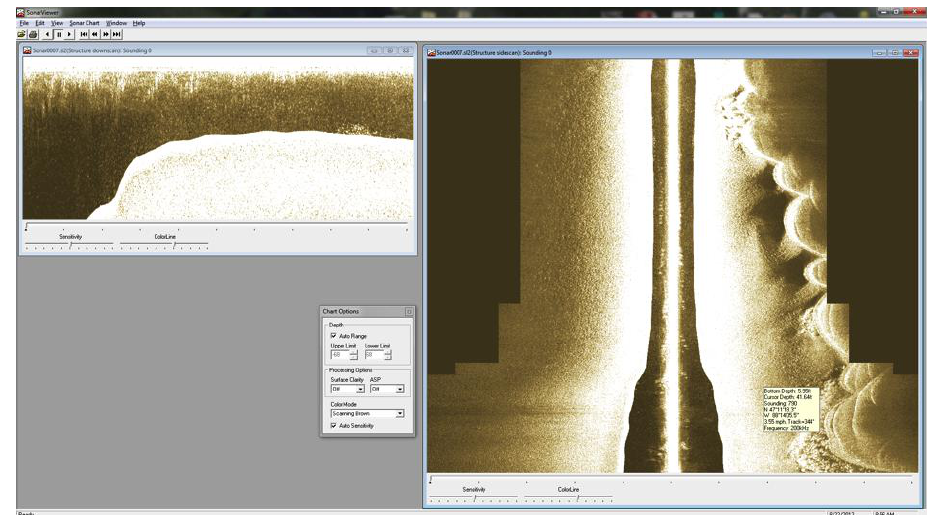
Figure 10. Side-oriented sonar image (Lowrance HDS7 from R/V Polar) of stamp sand falling into the “trough” (site 1 in Figure 5). ( Left ) The vertical scan of the 2.7 m-high “trough” east wall. ( Right ) The lateral scan of the stamp sand moving over the east wall escarpment and cascading into the “trough”. The dark central band in the horizontal image is the unrecorded track directly beneath the boat.